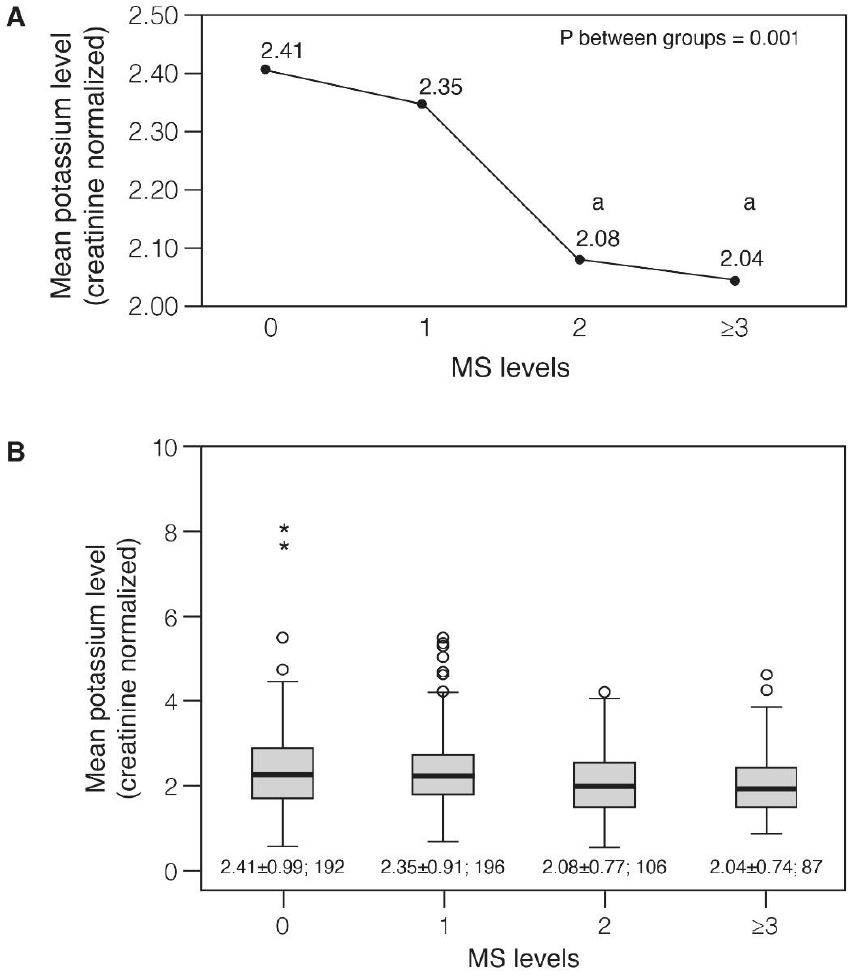
Figure 2. Mean potassium level as a function of MS levels. ( A ), Mean potassium levels according to MS levels; ( B ), Mean potassium levels and distribution according to MS levels – presented by BOX plot. Difference between groups was examined by one-way ANOVA test; Scheffe correction for multiple comparisons was implemented to test the difference between each group. “a” mean levels are significantly different than group “0” (no MS likelihood) (** p < 0.05). Abbreviations: MS, Metabolic syndrome.